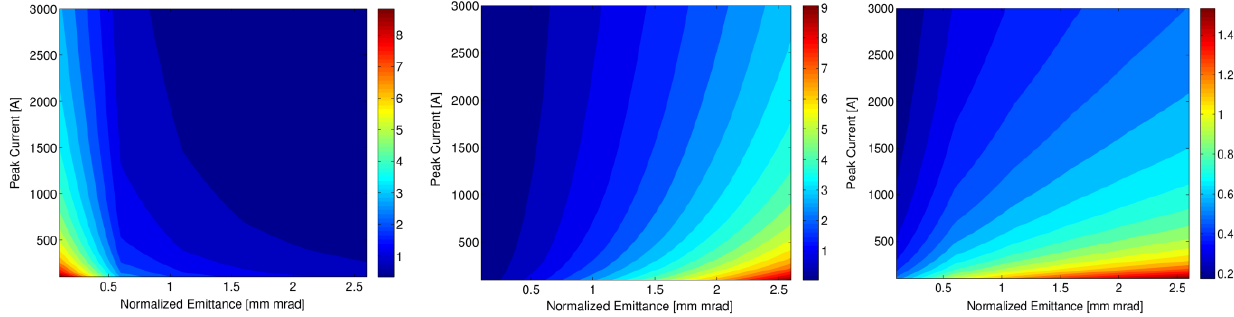
and  as function of electron bunch peak  